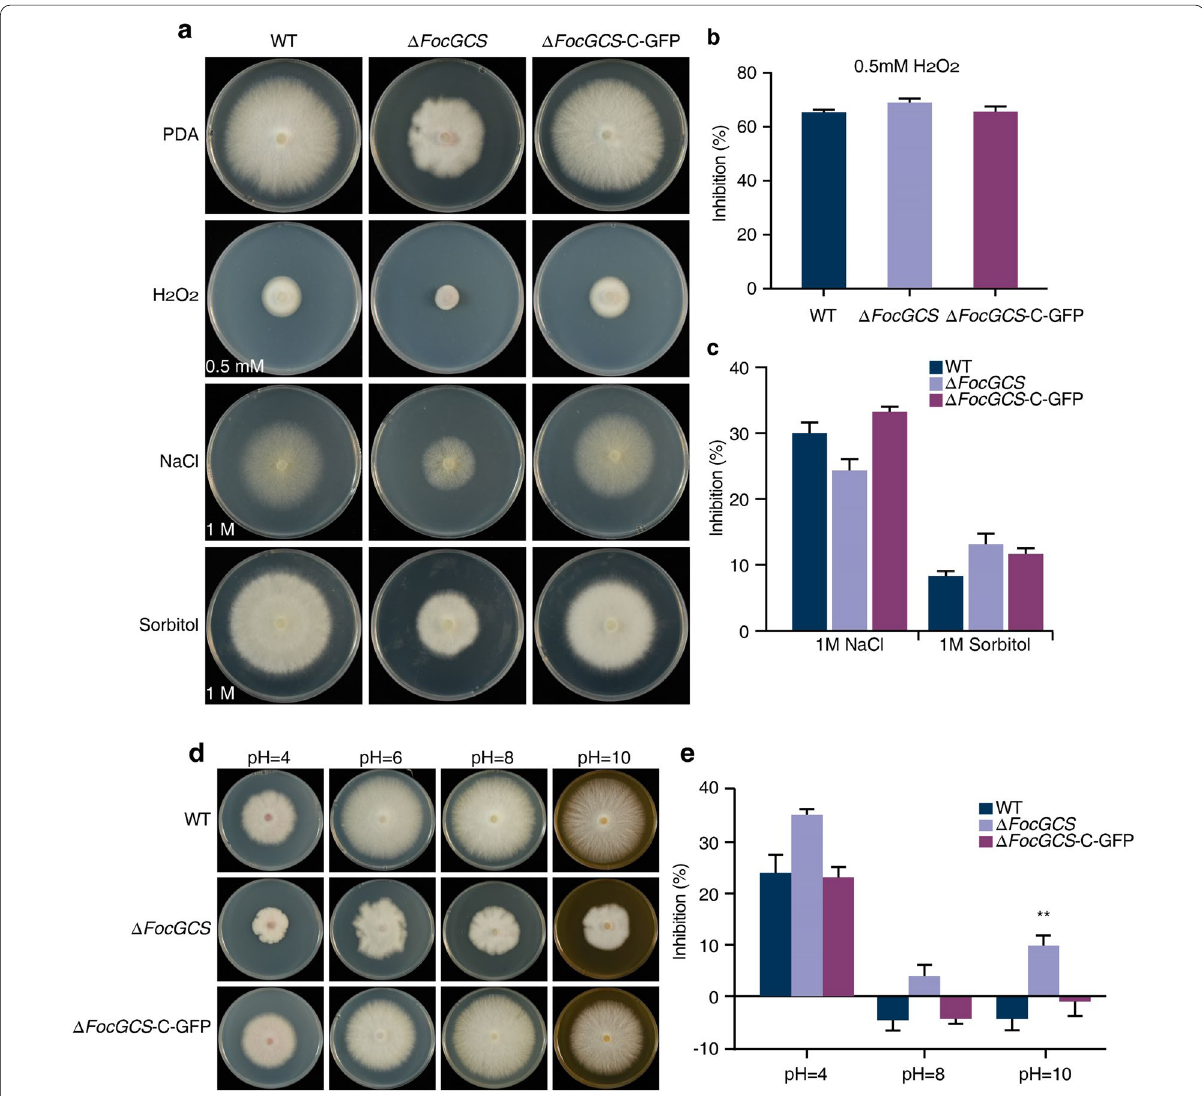
Fig. 7 Stress tolerance assays of the WT, ∆ FocGCS , and complemented strains. a Colony morphology of the indicated strains on PDA plates supplemented with 0.5 mM H 2 O 2 , 1 M NaCl, or 1 M sorbitol. Photos were taken after incubation at 28 °C for 5 days. b Colony growth inhibition incubated with 0.5 mM H 2 O 2 . c Colony growth inhibition incubated with 1 M NaCl or 1 M sorbitol. The inhibition rate was calculated by comparing the colony diameter under stress conditions with that under normal conditions. d Colony morphology of the indicated strains on PDA plates with different pH values. Photos were taken after incubation at 28 °C for 5 days. e Colony growth inhibition under different pH conditions. The inhibition rate was calculated by comparing the colony diameter under different pH conditions with that under condition of pH were calculated from three independent experiments, and asterisks indicate significant differences from the WT group (Student’s t ‑test, ** P <